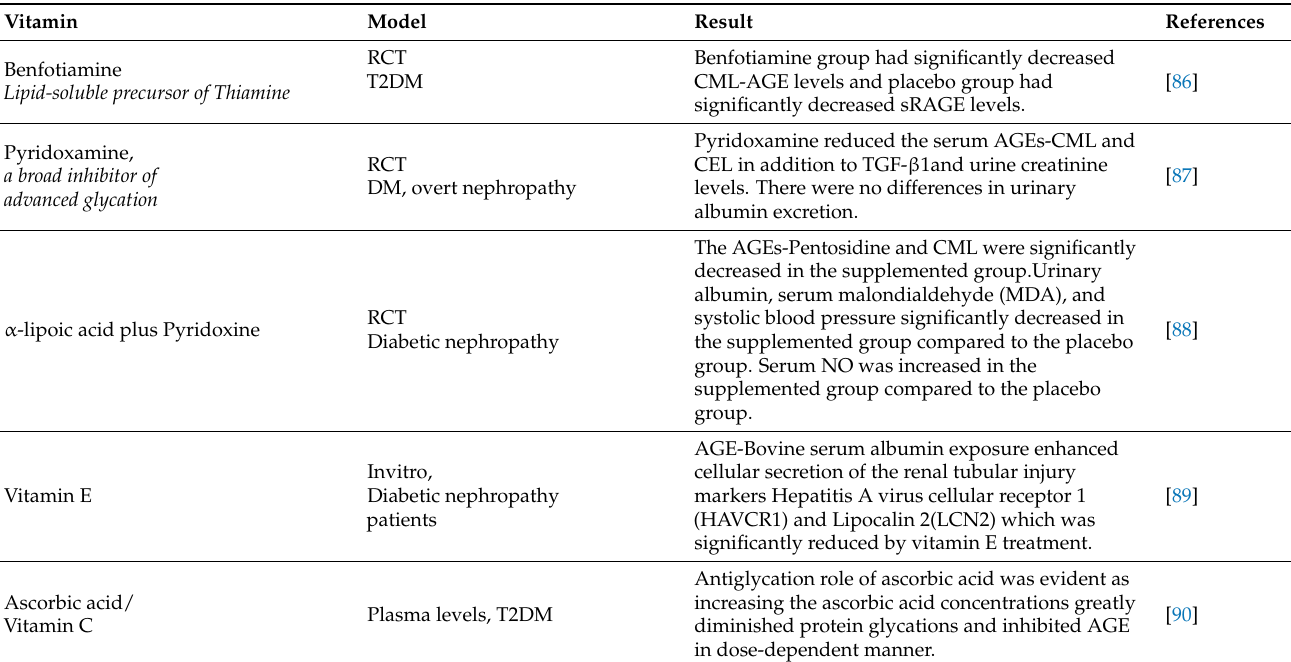
Table 4. Experimental and clinical findings on vitamins as therapeutic agents against AGEs in diabetic patients with and without renal complications.